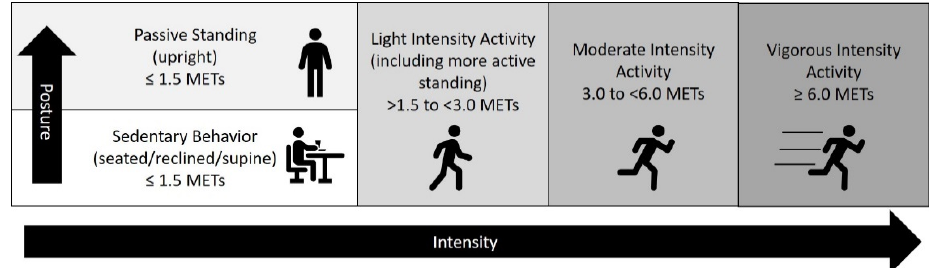
Figure 2. Proposed framework for classifying standing as part of the human movement spectrum.